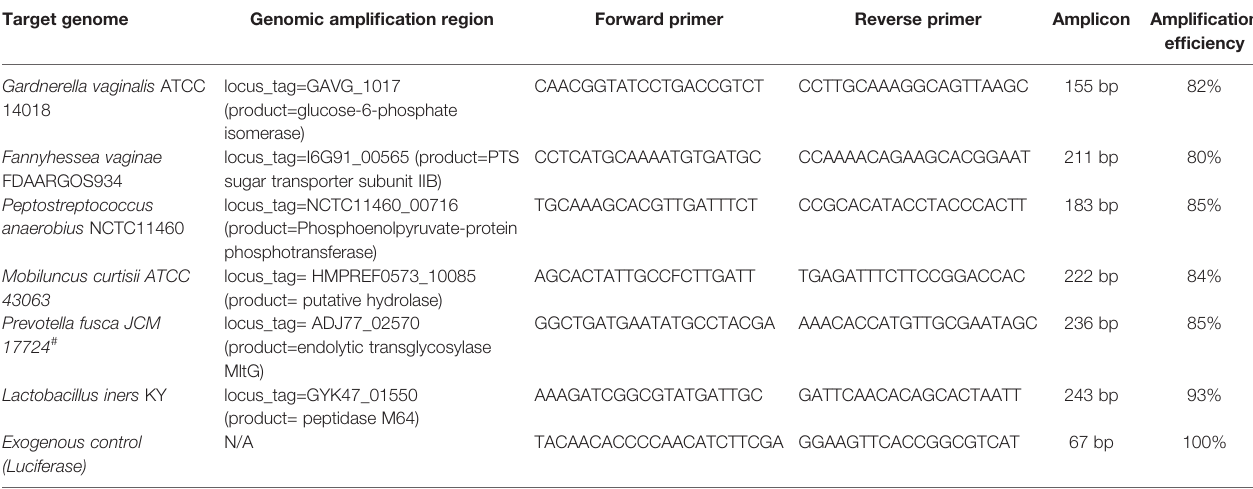
TABLE 1 | Speci fi c primers for the quanti fi cation of the six bacterial species present in the polymicrobial bio fi lm. Target